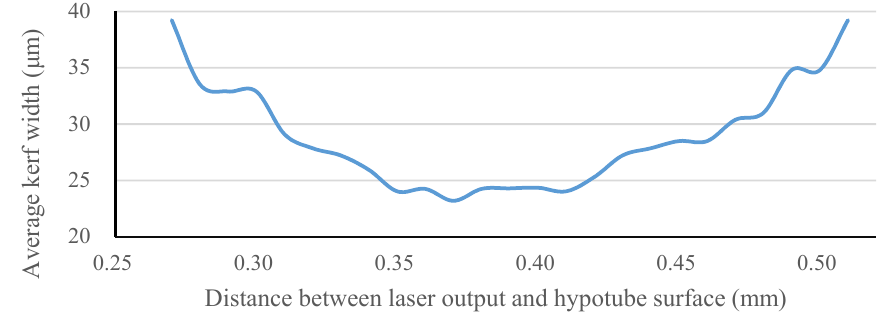
Figure 13. Kerf width vs. Z -direction distance between the laser source and hypotube surface.